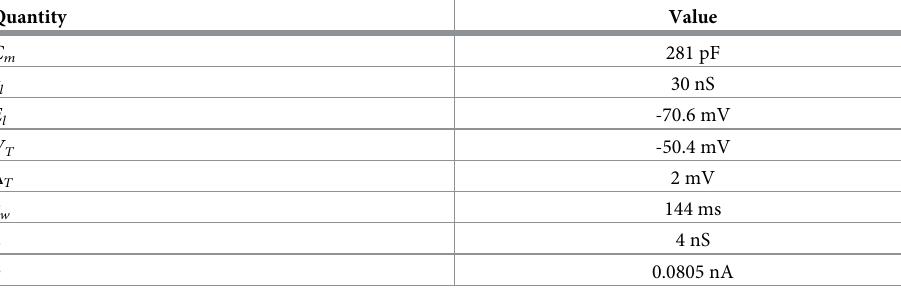
Table 2. Parameters for the AdExp model as given in